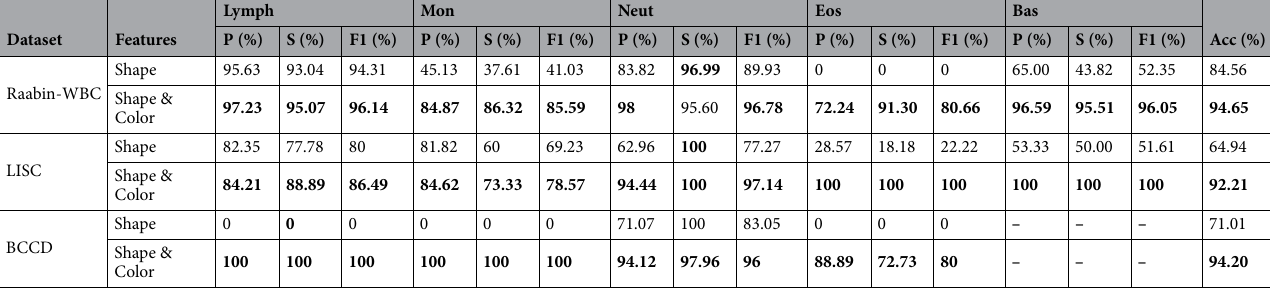
Table 5. The comparison of classification results using two modes of features. One mode uses only shape features and the other mode uses both shape and color features. The abbreviations: P (precision), S (sensitivity), F1 (F1-score), Acc (accuracy) . Bold values Illustrate the best-obtained